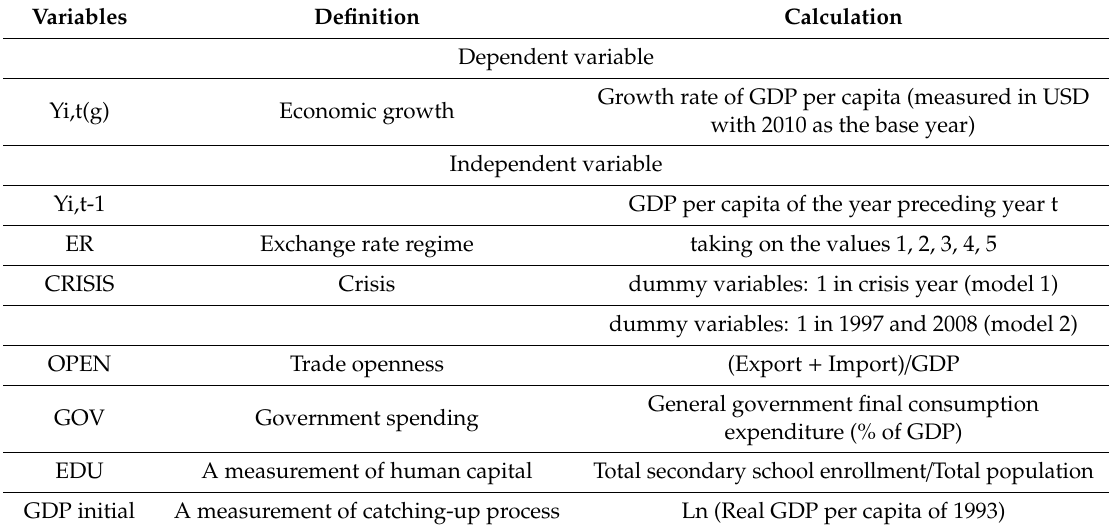
Table 2. A summary of